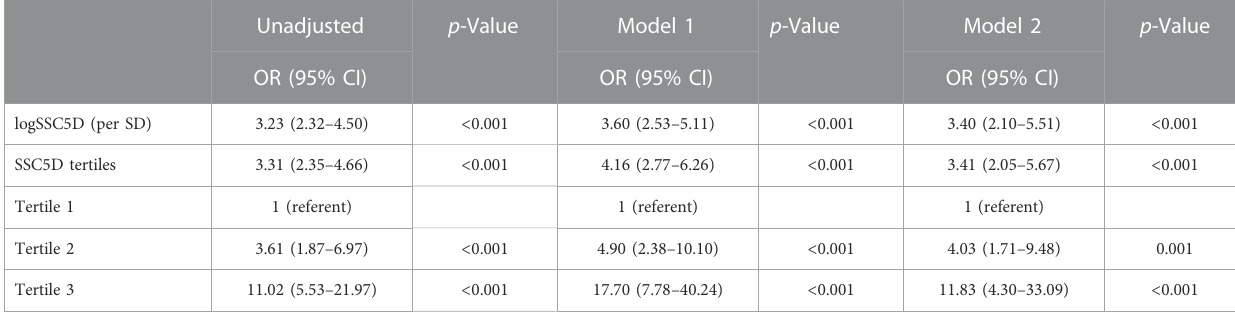
TABLE 3 Serum SSC5D levels were highly associated with the risk factors of HF. Unadjusted p